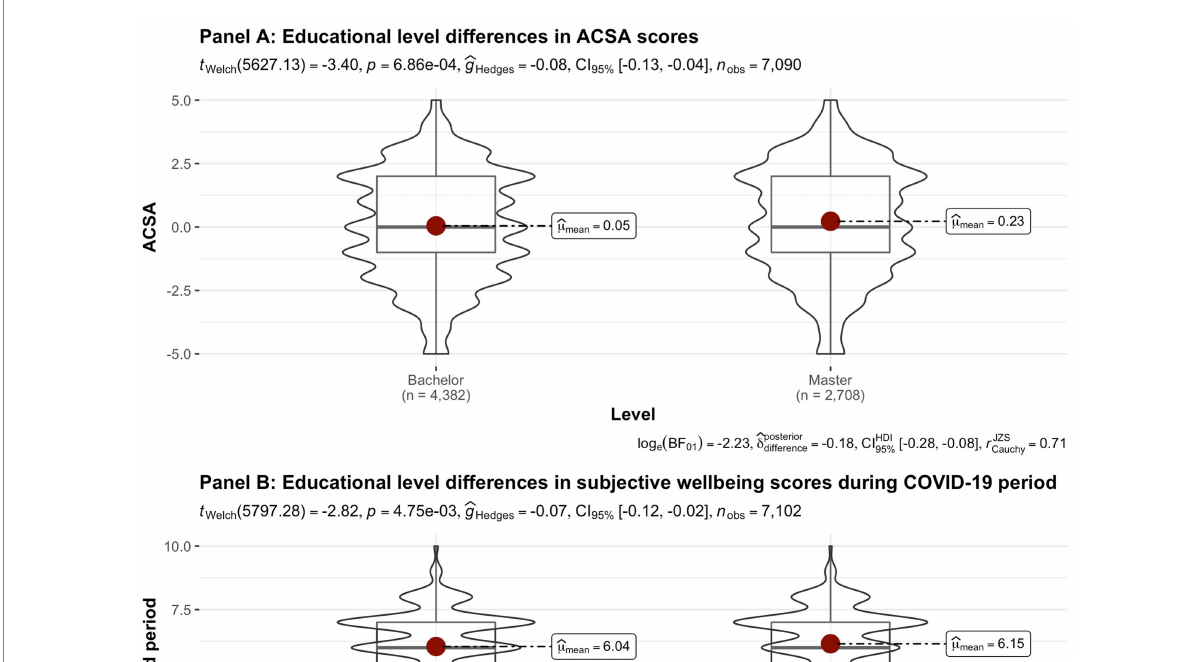
FIGURE 4 Mean ACSA (during the last 2 weeks, on a − 5 to +5 scale) and SWB-scores (during the COVID-19 period, and during the past 30 days, both on a 0–10 scale) comparing student groups during COVID-19 in terms of educational